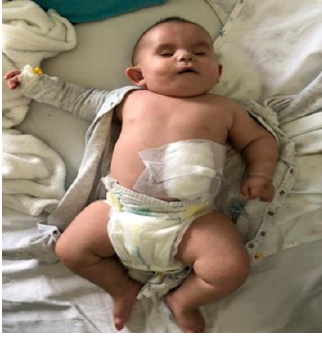
Figure 3. Clinical aspects at the age of seven months.